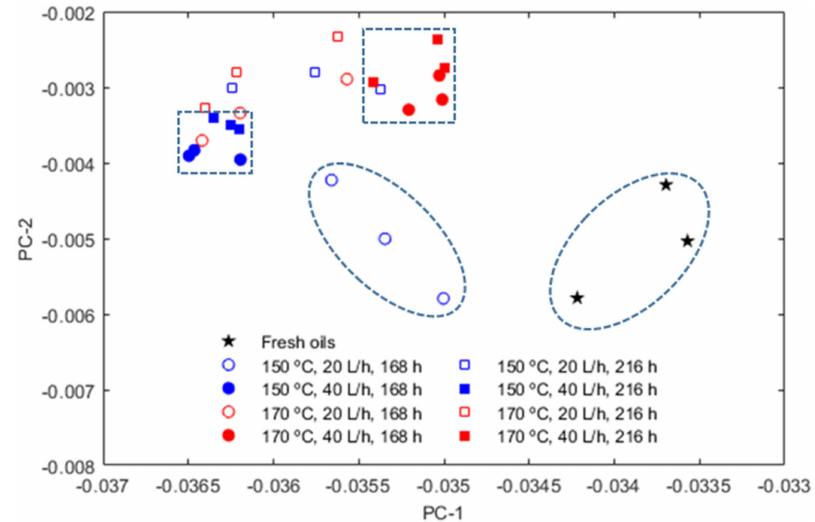
Figure 4. Principal component analysis for all the ATFs from the FTIR spectra